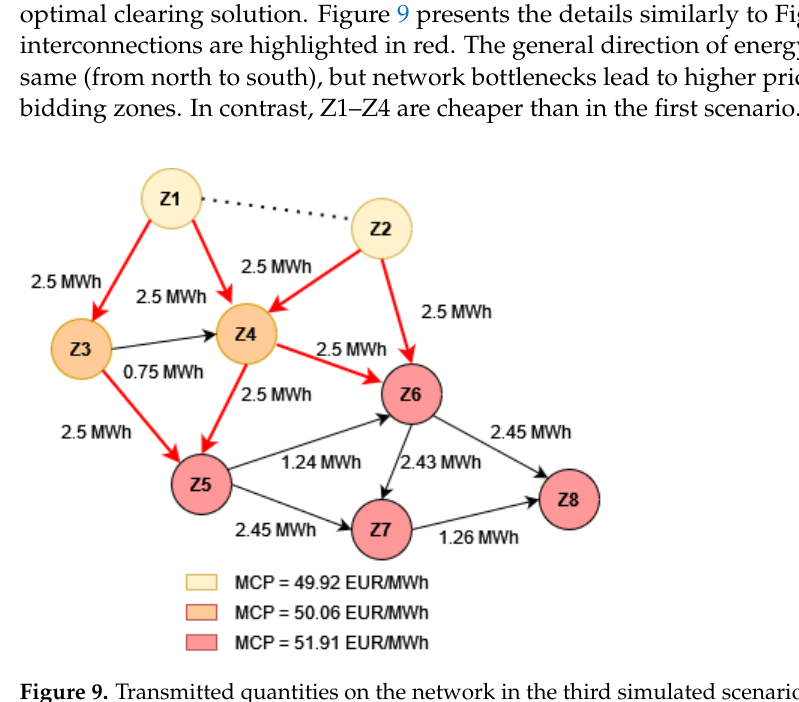
Figure 9. Transmitted quantities on the network in the third simulated scenario.